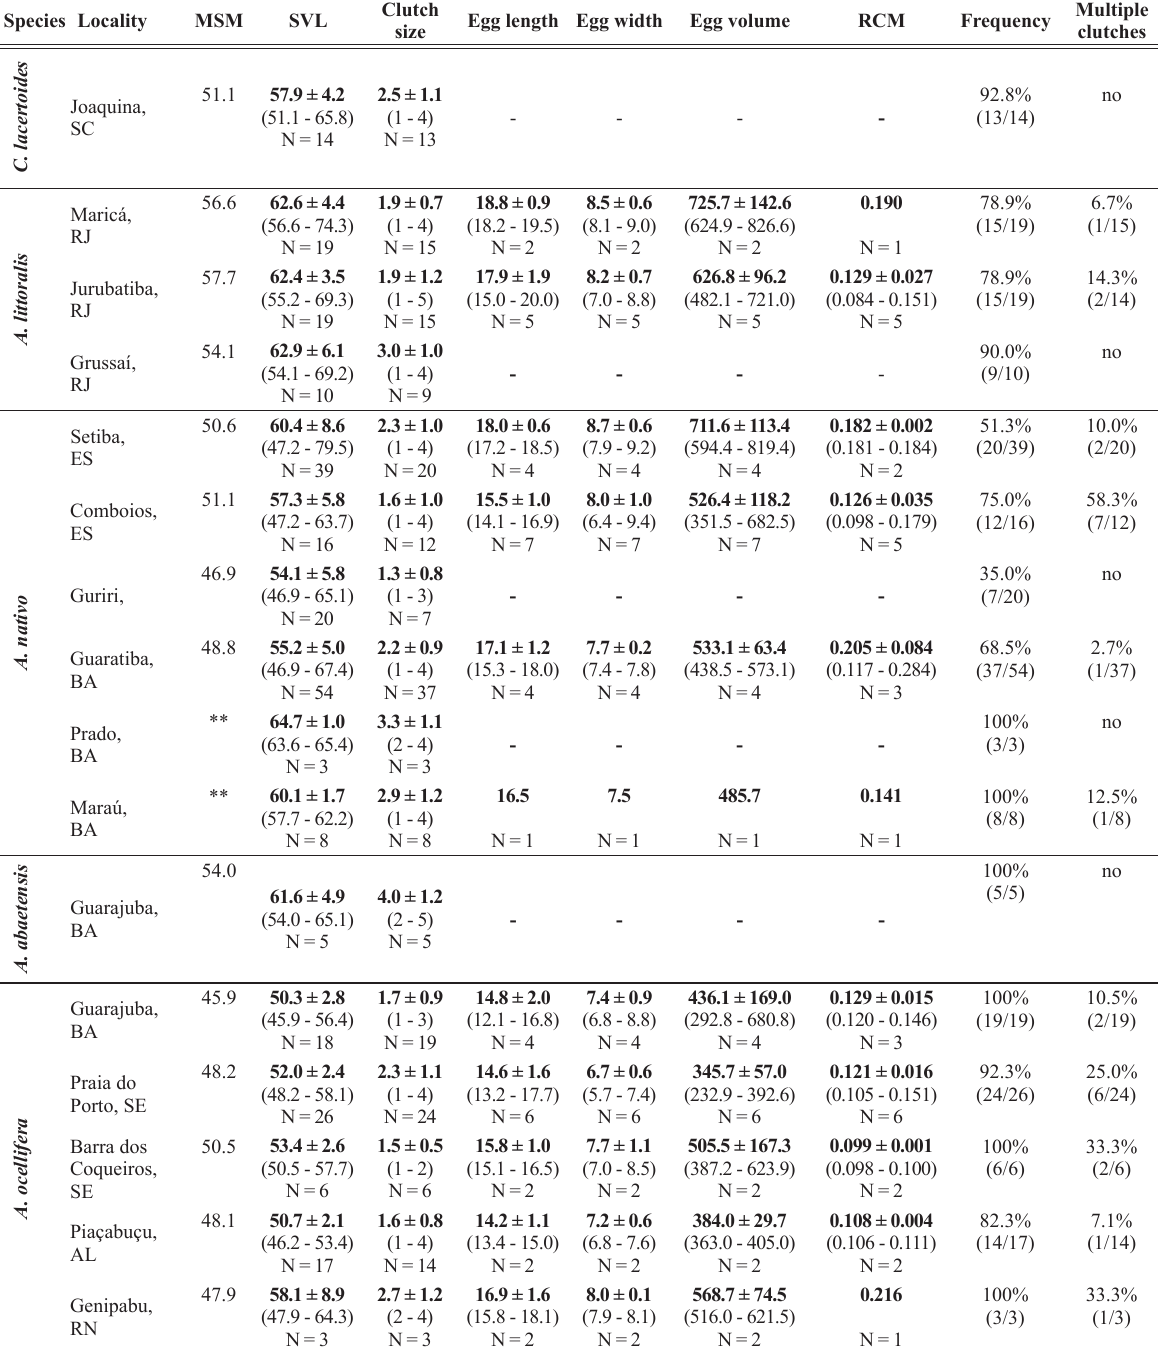
Figure 3 - Minimum size at maturity (MSM, in mm), mean snout-vent length of adult females (SVL, in mm), mean clutch size, egg length (in mm), egg width (in mm), egg volume (in mm 3 ), relative clutch mass (RCM), frequency of reproductive females (%) and frequency of occurrence (%) of multiple clutches for different populations and species of cnemidophorines along the eastern coast of Brazil. Values are represented by the arithmetic mean + one standard deviation with the range in parentheses and sample size below. State codes: SC - Santa Catarina, RJ - Rio de Janeiro, ES - Espírito Santo, BA - Bahia, SE - Sergipe, AL - Alagoas, RN - Rio Grande do